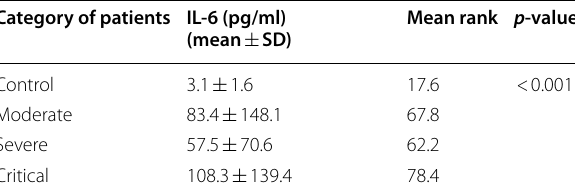
Table 4 Association of serum level of IL-6 (pg/ml) among different categories of COVID-19 patients and healthy